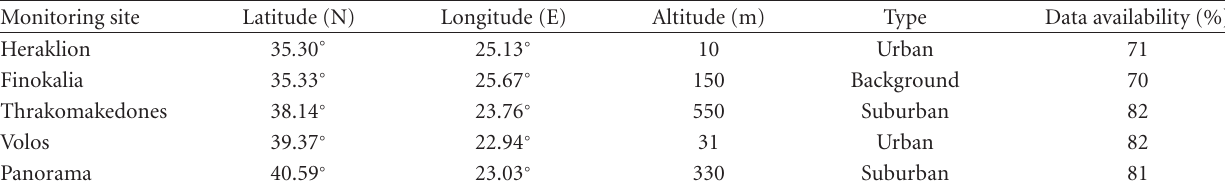
Table 1: PM10 monitoring sites 1 .